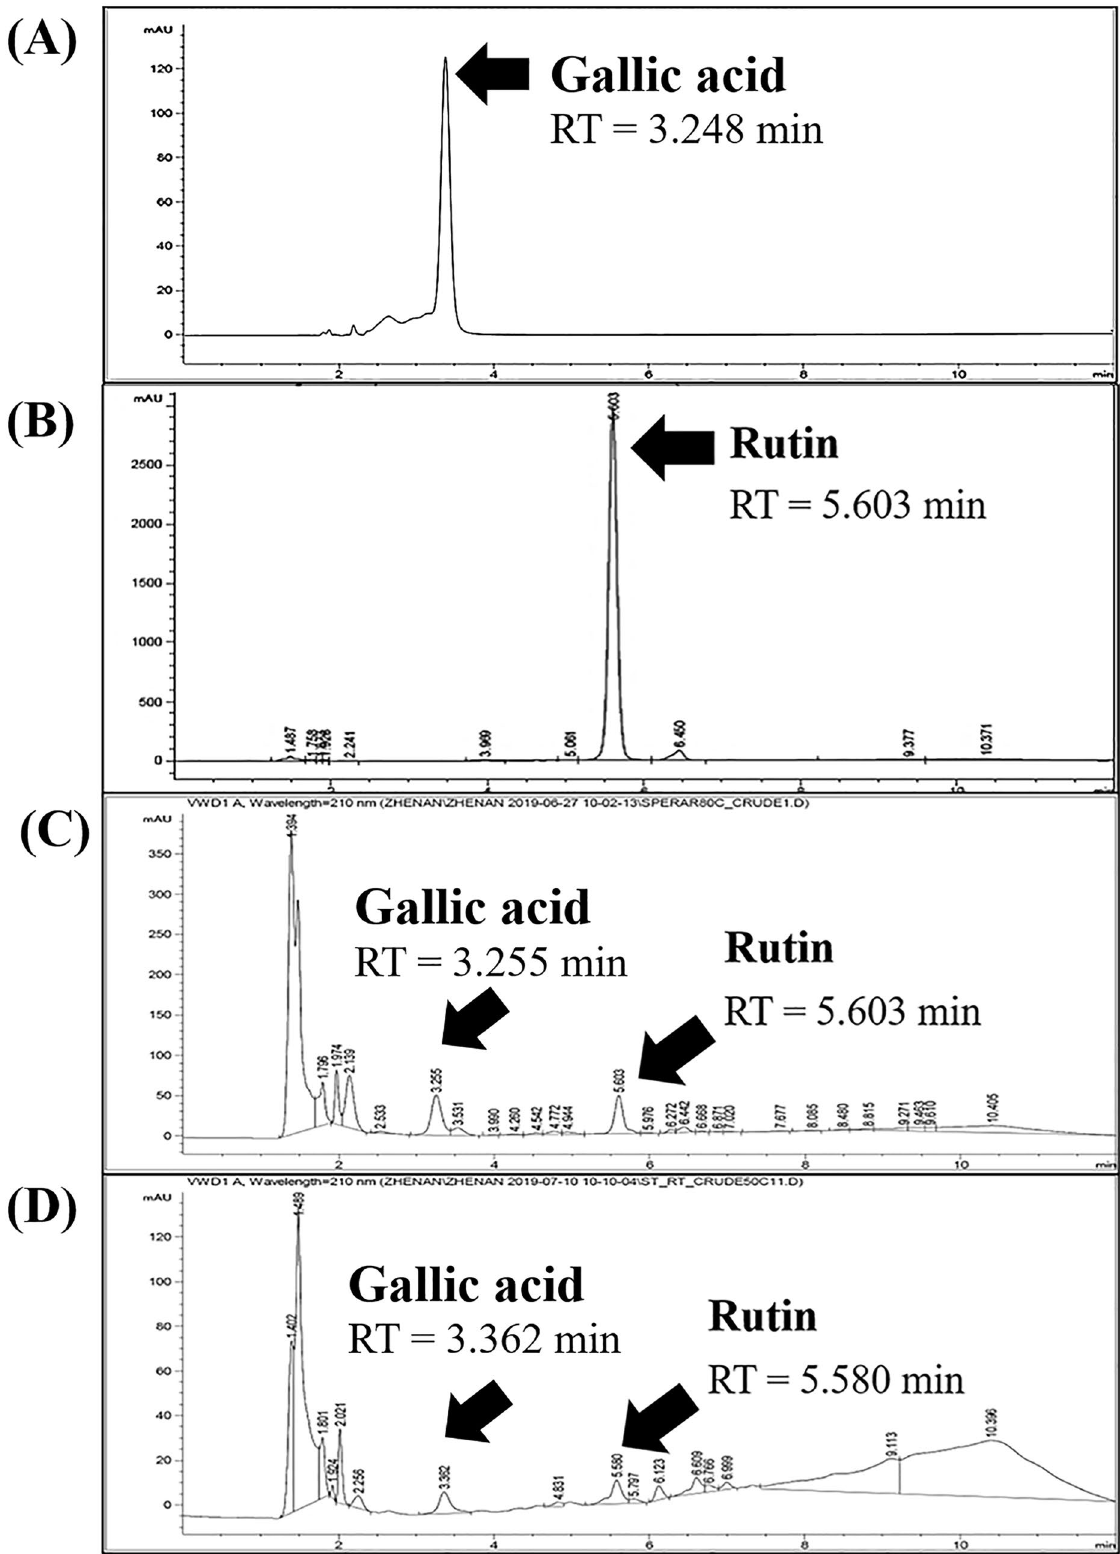
Figure 2. HPLC chromatograms of standard gallic acid ( A ), standard rutin ( B ), A. officinalis tip extracts (50 °C, 24 h) ( C ), and A. officinalis spear extracts (50 °C, 24 h) ( D